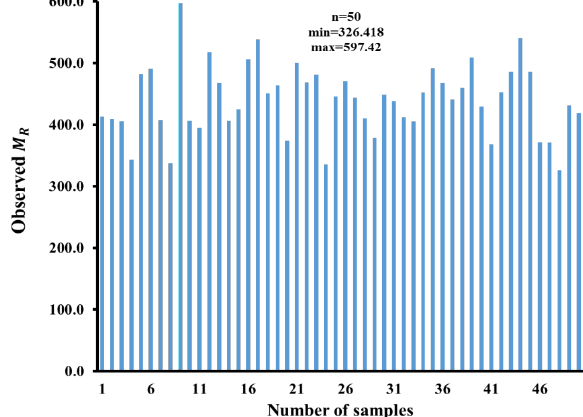
Fig. 8. Observed values of modulus ratio ( M R ) in each of 50 examined rock samples Figure 8: Observed values of modulus ratio ( M examined rock